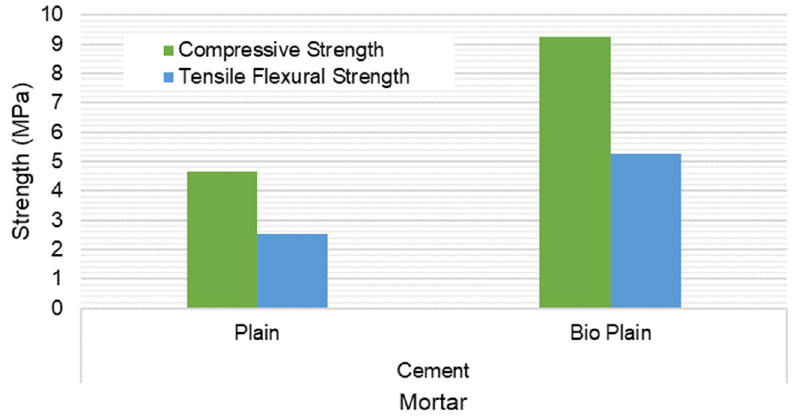
Figure 20. Compressive and tensile flexural strength at 28 days for the cement-based mortar with and without biostabiliser. Coefficient of variation for tensile flexural strength (CoV) per family of mortar: cement mortar: 1.3%; cem+bio: 4.9%. Coefficient of variation for compressive strength (CoV) per family of mortar: cement mortar: 4.3%; cem+bio: 3.6%.